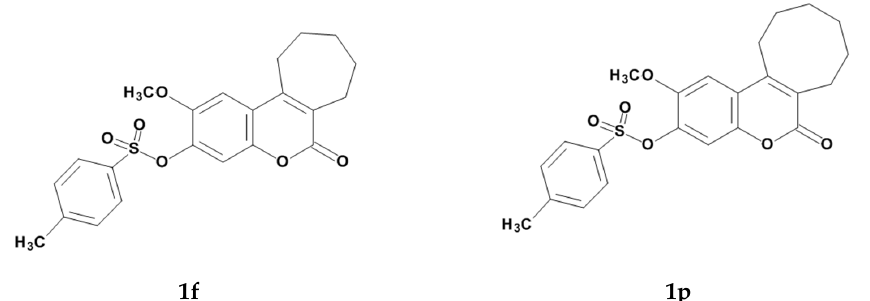
Figure 1. Chemical structure of the two most potent sulfonate derivatives synthesized by El ‐ Gamal, named 1f and 1p [18].